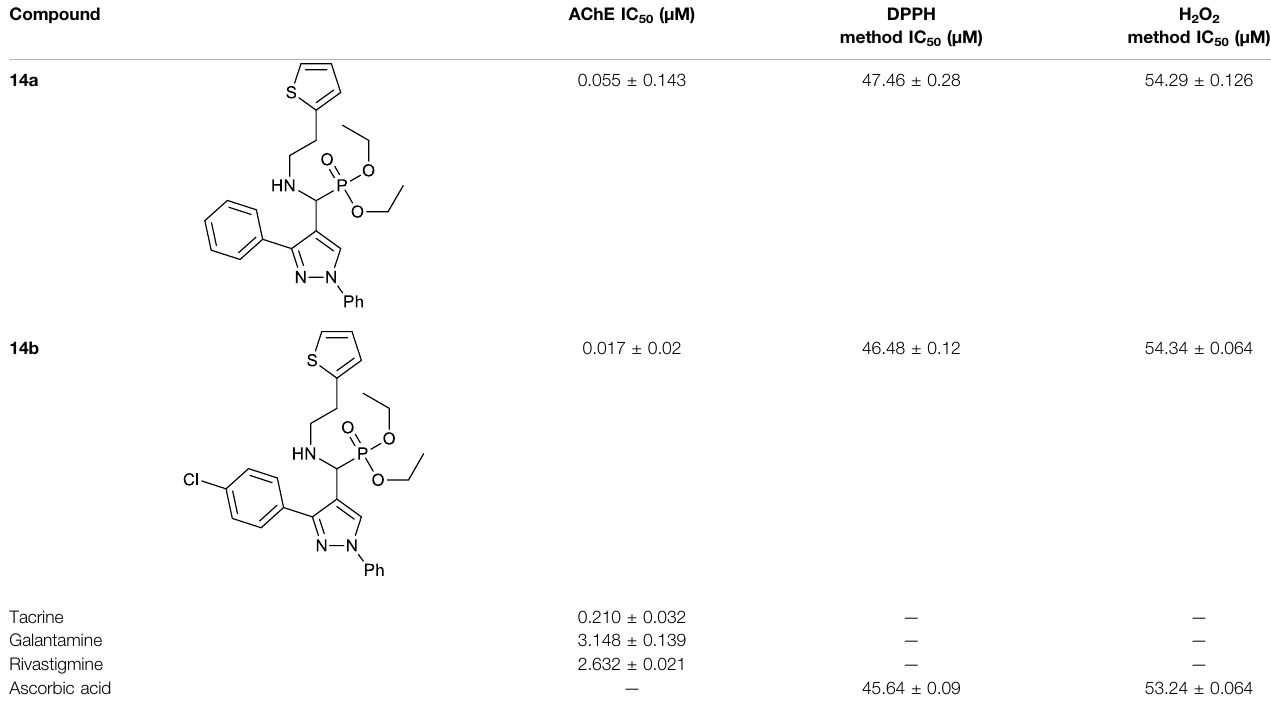
TABLE 1 | Antichloline esterase activities of compound 14 .